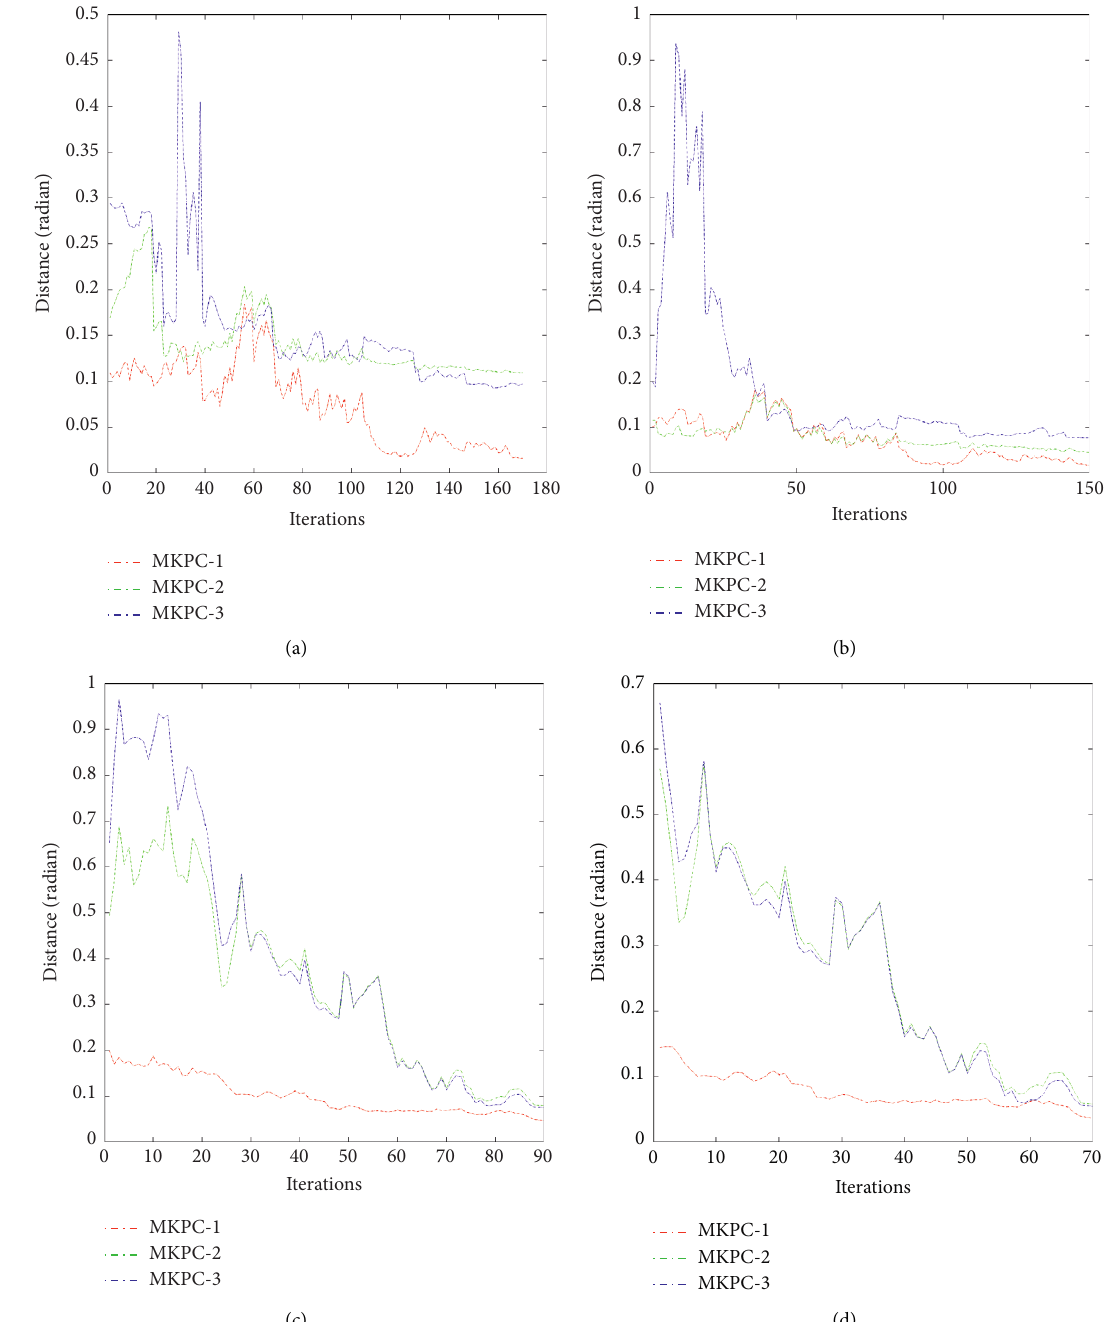
Figure 3: Angles between the first three kernel principal components (red, green, and blue) computed by the proposed method and the standard MKPCA. (a, b) Results of two-dimensional example for data capacity 200; n is 30 and 50, respectively; σ � 1 for Gauss function. (c, d) Results of digit “0” matrix set for data capacity 120, n is 30 and 50, respectively; σ � 1 for Gauss